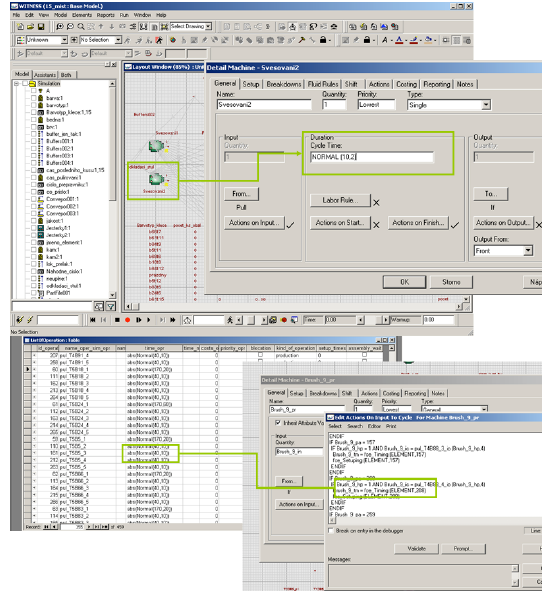
Fig. 8. Changing of